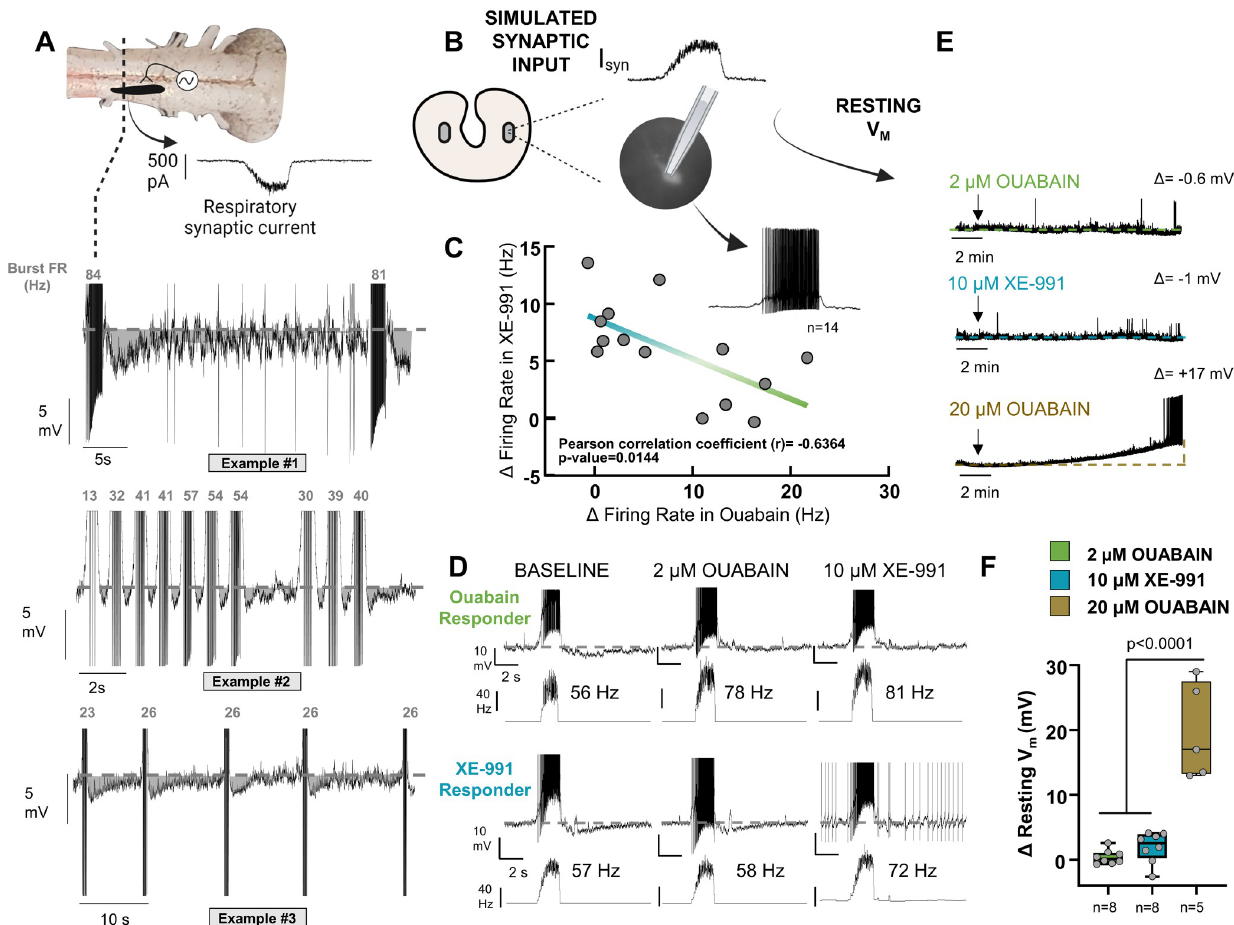
Fig 4. The dynamic Na + pump and Kv7 channels contribute to regulation of firing rate through activity-dependent feedback. (A) Identified vagal motoneurons receiving input from the respiratory rhythm generator exhibit slow afterhyperpolarization following rhythmic burst firing, demonstrating that physiological bursting is followed by prolonged membrane hyperpolarization, consistent with recruitment of the dynamic Na + pump and Kv7 channels. (B) Current clamp recordings of firing in response to stimulation of current input that mimics synaptic drive in slices. (C) Each neuron showed differential changes in firing rate in response to 2 μ M ouabain and 10 μ M XE-991 along a spectrum ( n = 14 from N = 8 animals). (D) Top example shows a neuron with a large contribution of the Na + pump for the control of firing rate, with little input from Kv7 channels. Bottom example shows a neuron with little contribution from the pump but a large role for Kv7 in controlling firing rate. (E) Example recordings of resting membrane potential in silent neurons during application of 2 μ M ouabain ( n = 8 neurons from N = 4 animals), 10 μ M XE-991 ( n = 8 neurons from N = 4 animals), and 20 μ M ouabain to block the “housekeeper” form of the Na + pump ( n = 5 neurons from N = 3 animals). (F) Mean data for effects of each drug on resting membrane potential. The data underlying this figure can be found in S1